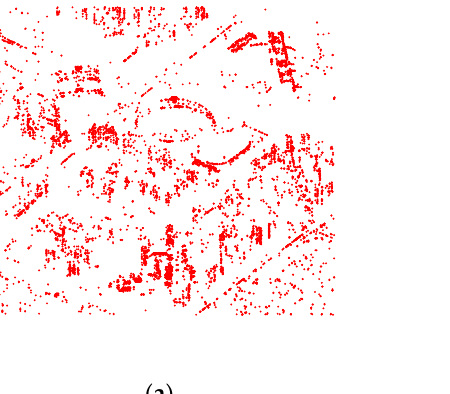
network constructed by Delaunay triangulation.